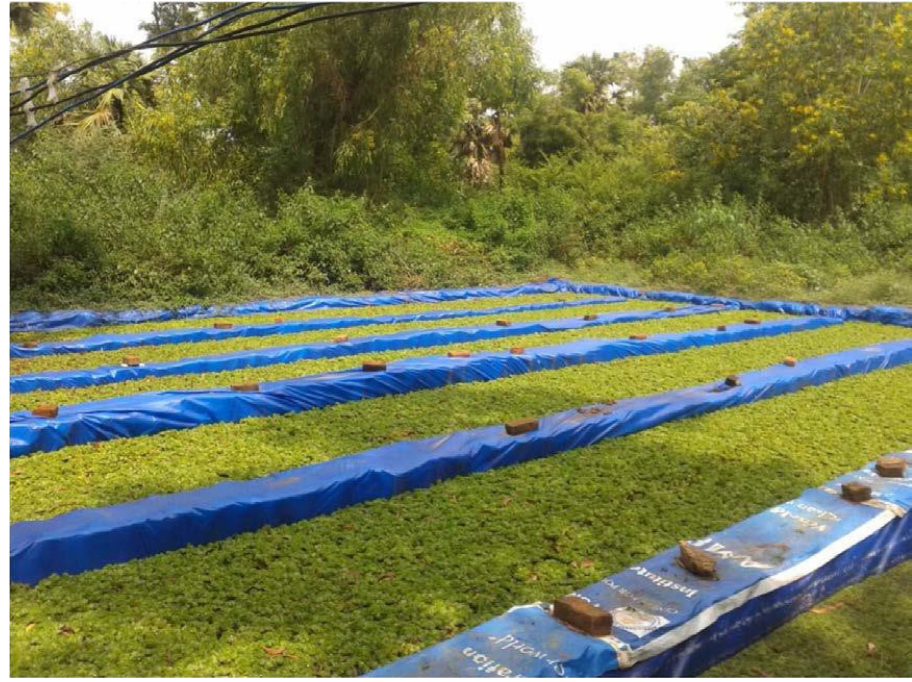
Figure 2. Another SHEFROL plant treating sewage continuously. It is planted with Salvinia molesta .